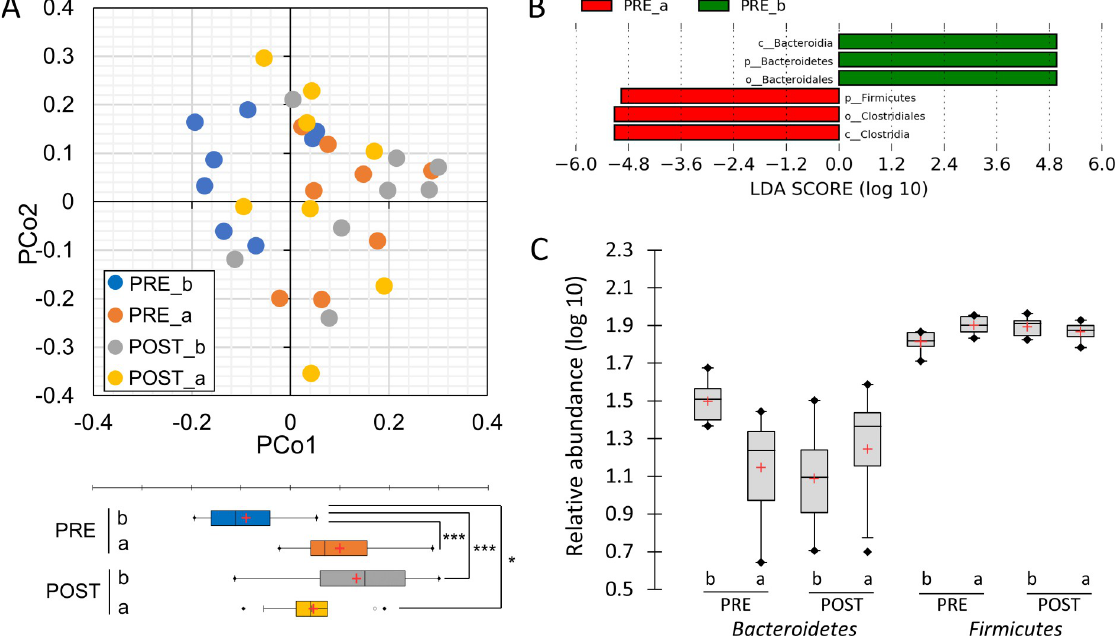
Fig 2. Difference of fecal microbiota composition before and after the race during the pre-observation and LEX-ingestion periods. (A) Principal coordinate analysis (PCoA) plots (weighted UniFrac analysis). (B) Linear discriminant analysis (LDA) effect size (LEfSe) analysis plot in fecal microbiota between four groups (PRE_b, PRE_a, POST_b, and POST_a). LDA scores (log10) > 2 and p < 0.05 are listed. (C) Histogram of the relative distribution of phyla Bacteroidetes and Firmicutes . PRE: pre-observation period. POST: LEX-ingestion period. b: before the race. a: after the race. For all box-and-whisker plots, center lines represent the median and the box edges represent the first and the third quartiles with mean (Red +). Statistical significance was determined using repeated measures ANOVA with Bonferroni’s correction for PCoA plot. � and ��� indicate significant differences between p < 0.05 and p < 0.001, respectively.